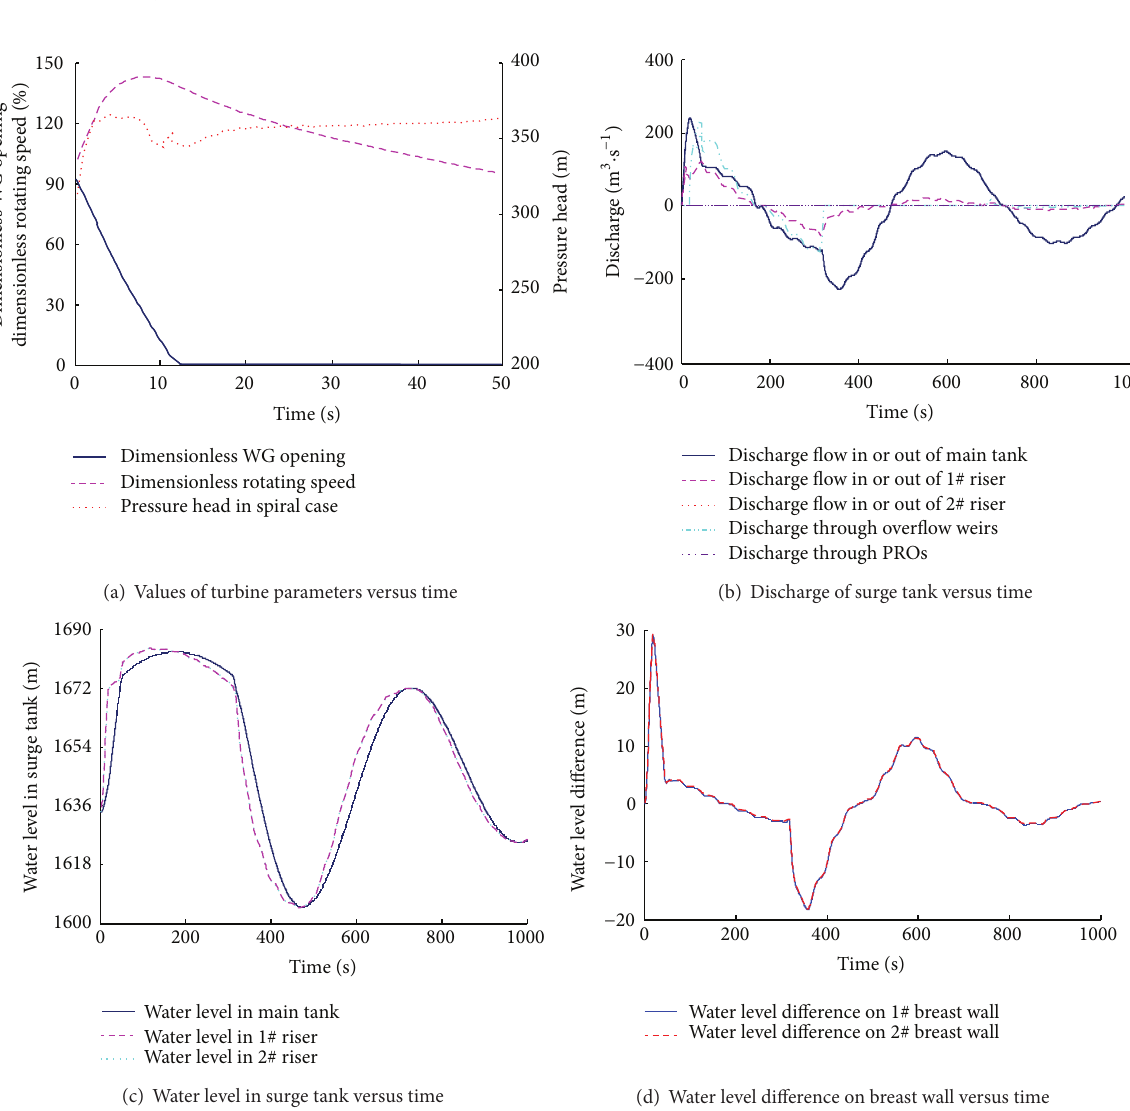
Figure 4: Numerical results of simultaneous load